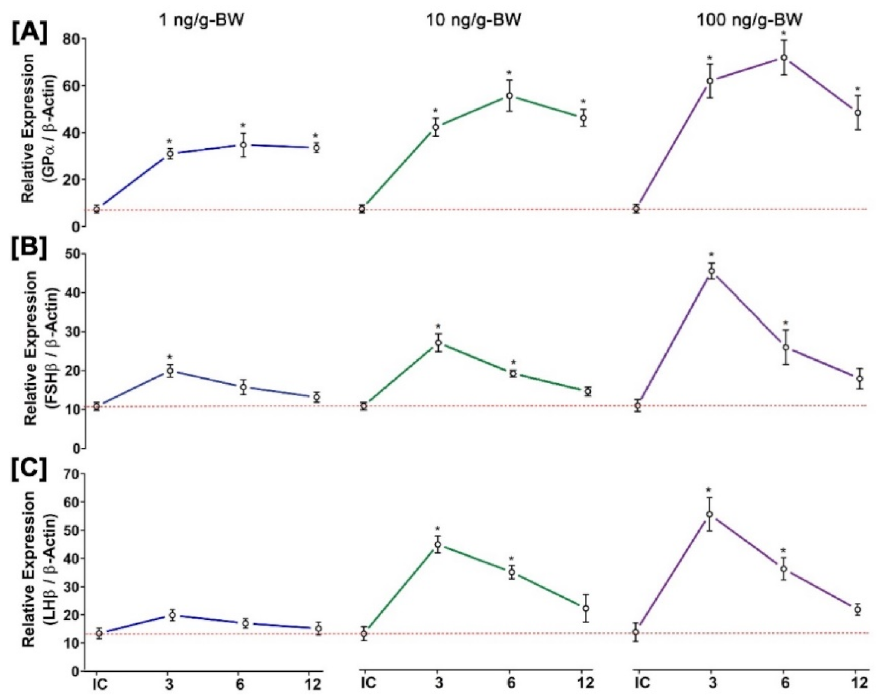
Figure 10. Time- and dose-dependent in vivo effects of GnRH1 peptide on mRNA expression levels of three GtH subunits in the pituitary of small yellow croaker: ( A ) GP α , ( B ) FSH β , and ( C ) LH β . GnRH1 peptide was injected at concentrations of 1, 10, and 100 ng/g-BW. Asterisks indicate significant differences ( p < 0.05) compared to zero time point initial control (dotted